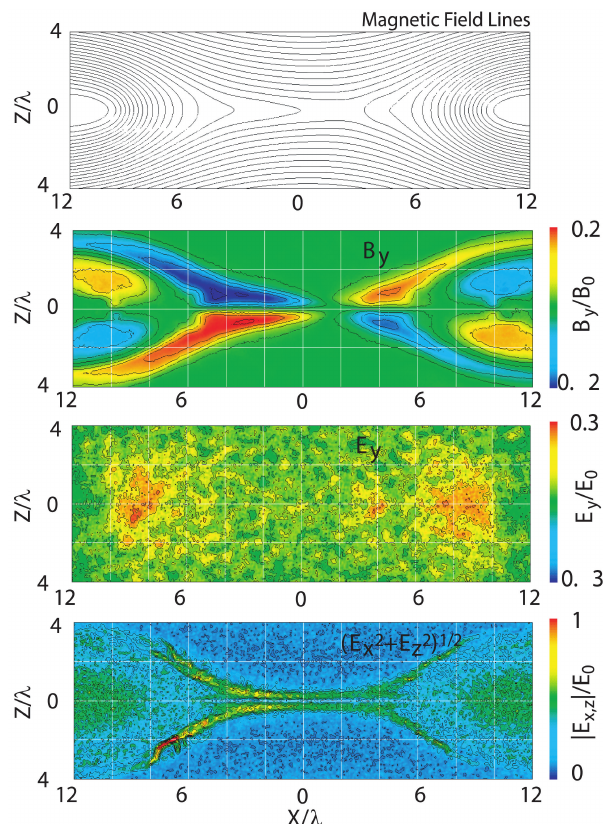
Fig. 4. Characteristic field structures obtained in a particle-in-cell simulation of collisionless magnetic reconnection (Hoshino, 2001). The magnetic field By is normalized by the initial lobe magnetic field B 0 , and the electric field is normalized by E 0 = B 0 V A /c . Note that the Earth is to the right in this